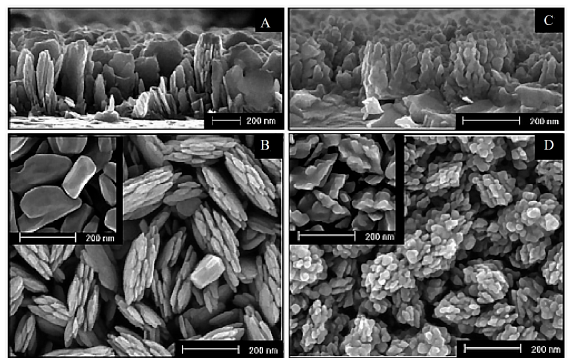
Figure 8. Typical HR-SEM images of Si-doped hematite films on TCO obtained from USP ( A , B ) and APCVD ( C , D ): a and c are side-view, b and d top-view images; ( B , Inset) Hematite grains for undoped USP ( D , Inset) Hematite grains for undoped APCVD electrodes. Adapted with permission from [67]. Copyright 2006 American Chemical Society.